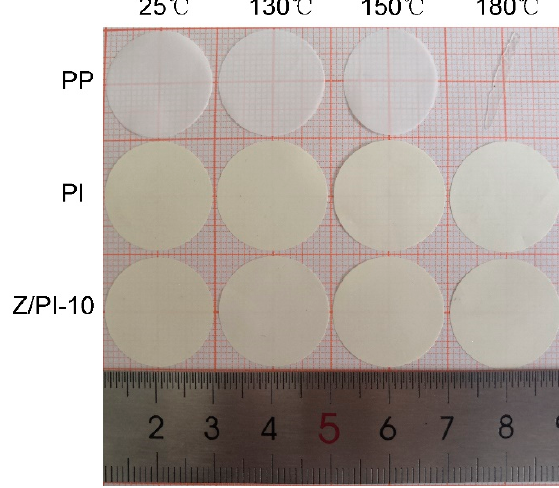
Figure 4. ( a ) DSC and ( b ) TGA curves of PP,PI, and Z/PI-10 separator.